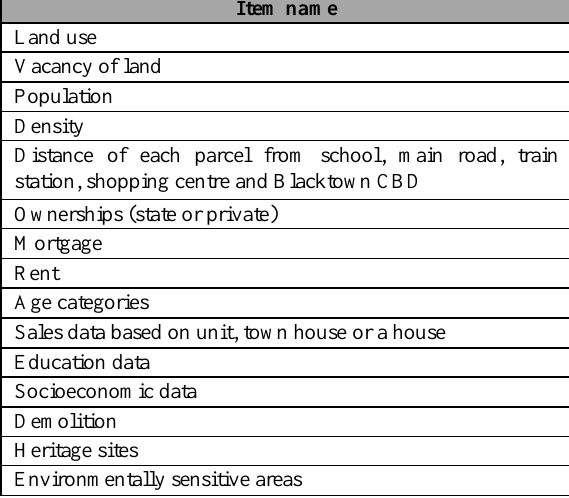
Figure 6. PSS used in designing scenarios at Blacktown, NSW